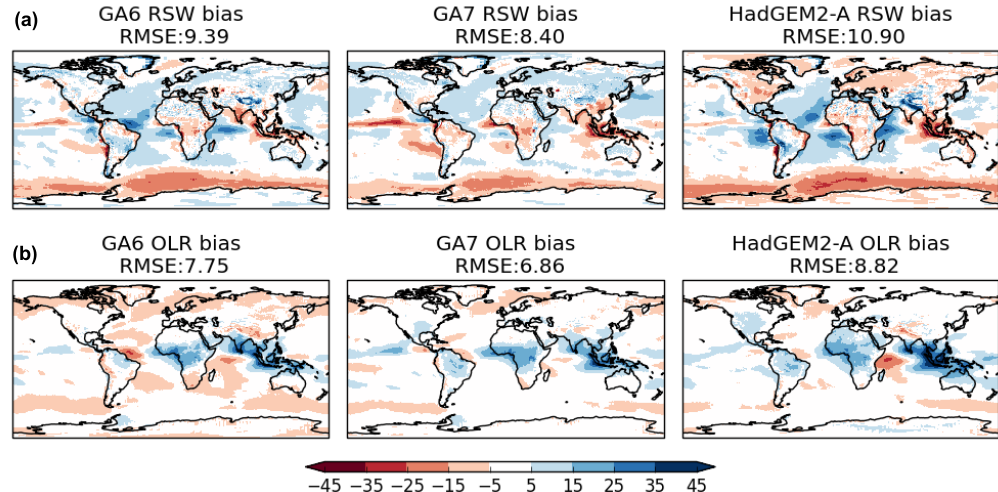
Figure 13. Multi-annual mean bias in RSW (a) and OLR (b) (Wm − 2 ) against CERES-EBAF for GA6, GA7 and HadGEM2-A. The spatial root-mean-square error (RMSE) is shown at the top of each panel.